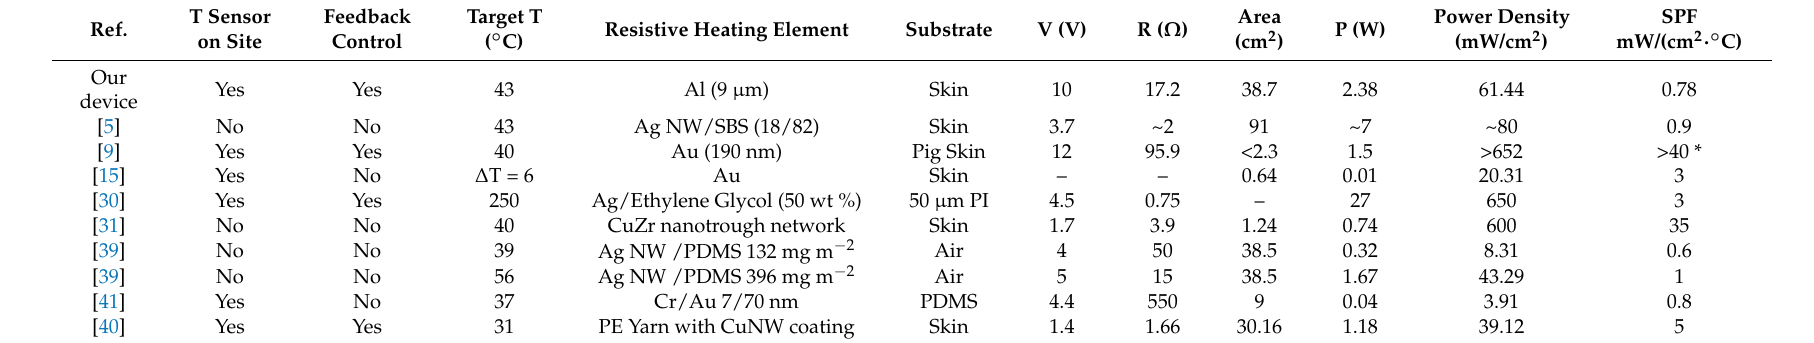
Table 1. Compiled information about different stretchable